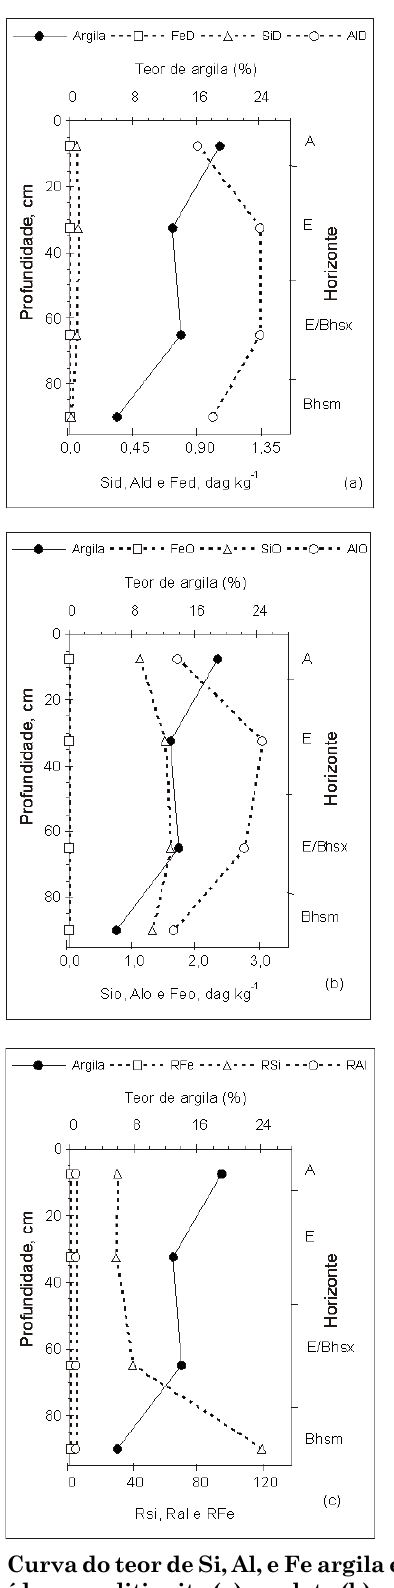
Figura 2. Curva do teor de Si, Al, e Fe argila e formas extraídas com ditionito (a), oxalato (b) e relações RSi (Sio/Sid), RAl (Alo/Ald), RFe (Feo/Fed) - (c) em profundidade no Espodossolo Cárbico órtico dúrico -